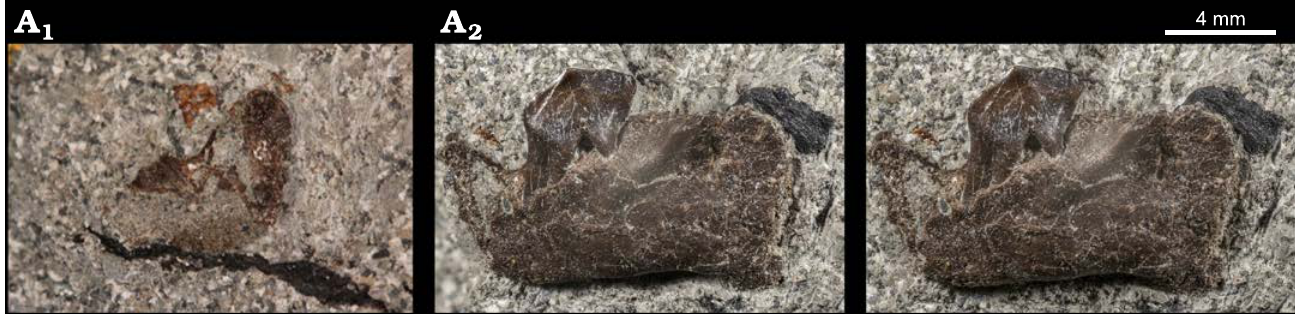
Fig. 3. Partial left dentary with p4 in situ in referred specimen, NMV P252730, of the cimolodontan multituberculate Corriebaatar marywaltersae Rich, Vickers-Rich, Flannery, Kear, Cantrill, Komarower, Kool, Pickering, Trusler, Mor ton, van Klaveren, and Fitzgerald, 2009, Flat Rocks locality, Eumeralla Formation, Barremian, Lower Cretaceous of Victoria, Australia, photographed as embedded in rock matrix. Medial view of small anterior section (A 1 ) and lateral view of large posterior section (A 2 ,